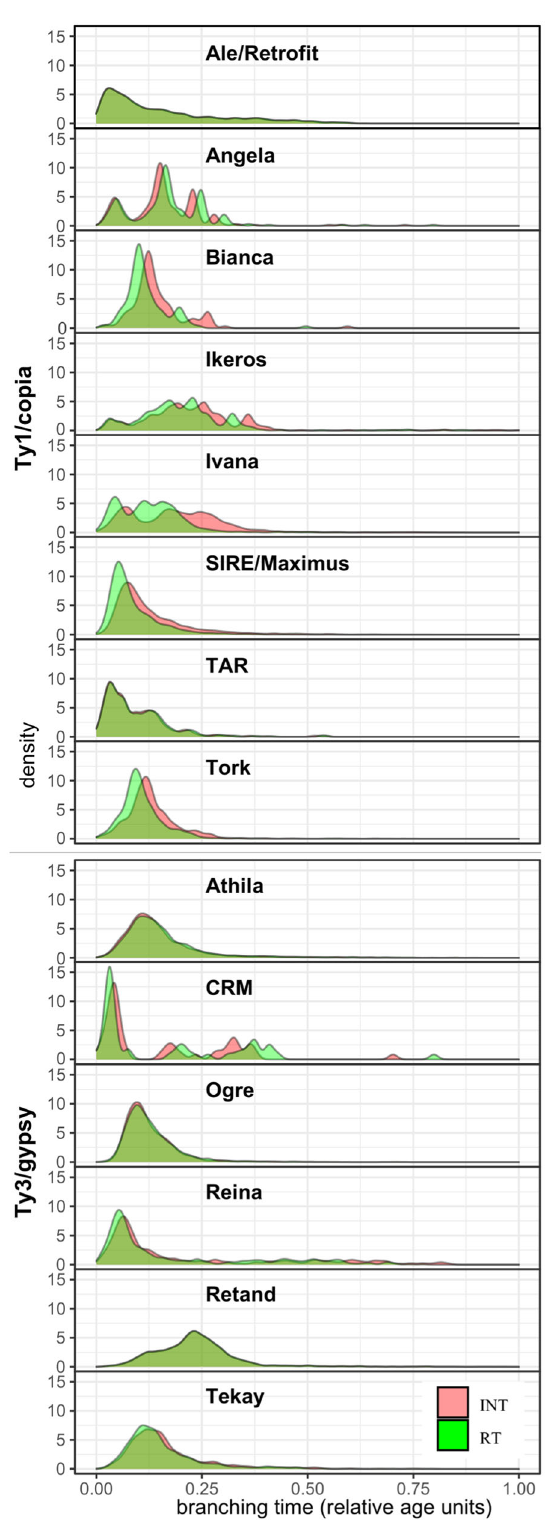
Fig. 2 | Ages pro fi le of Class I TE lineages. Relative ages are inferred from the branching distribution of neighbor-joining trees (Supplementary Figure 6),built from the INT (red) and RT (light green) protein domains, respectively. Source data are provided as a Source Data fi